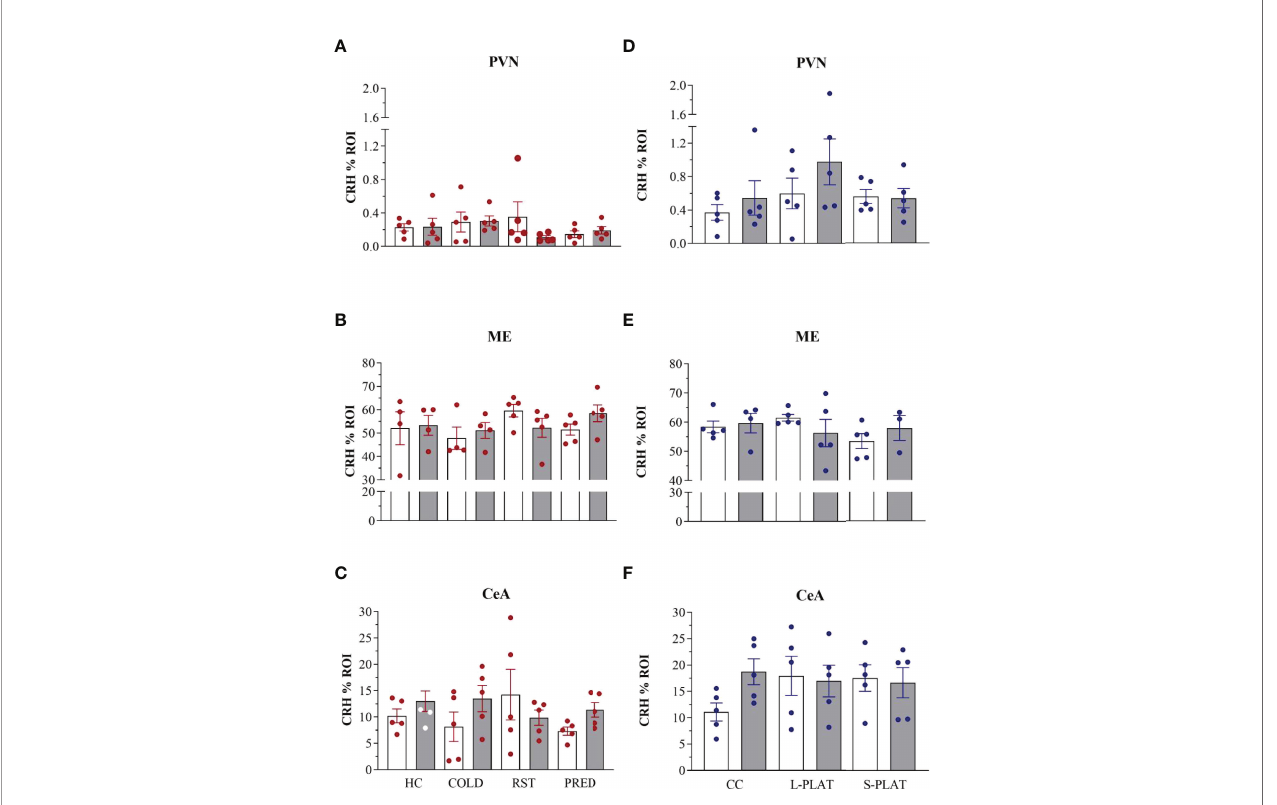
FIGURE 5 | CRH-ir in the PVN, ME and CeA after several stressors (A – C) or after PSD (D – F) . Quanti fi cation of staining is shown for each individual and the columns represent the mean ± SEM of 4 to 5 rats/subgroup. HC, home cage; RST, restraint stress; PRED, predator odour; CC, container control; L-PLAT, large platform; S-PLAT, small platform. White columns represent single or 1-day exposure and grey columns, repeated or 4-day exposure.